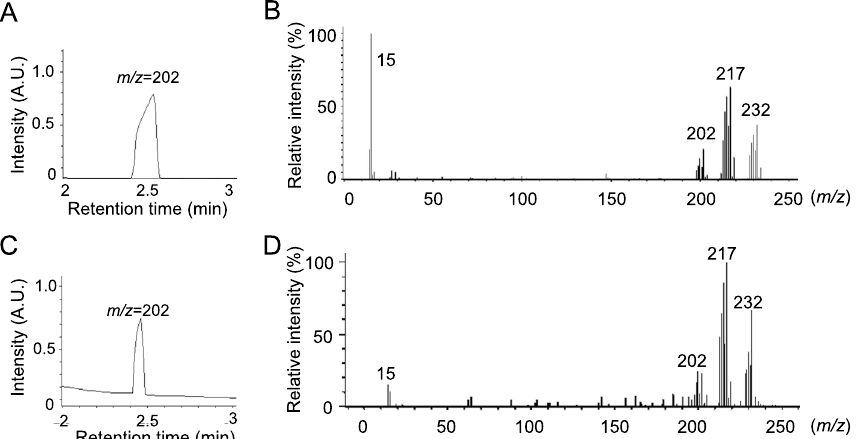
Figure 6. GC/MS analysis of mouse expirate after treatment with dimethylmercury or bismethylmercury sulfide . Chemicals in the exhaled air of mice given a single injection of ( A , B ) 0.1 mmol/kg DMeHg and ( C , D )